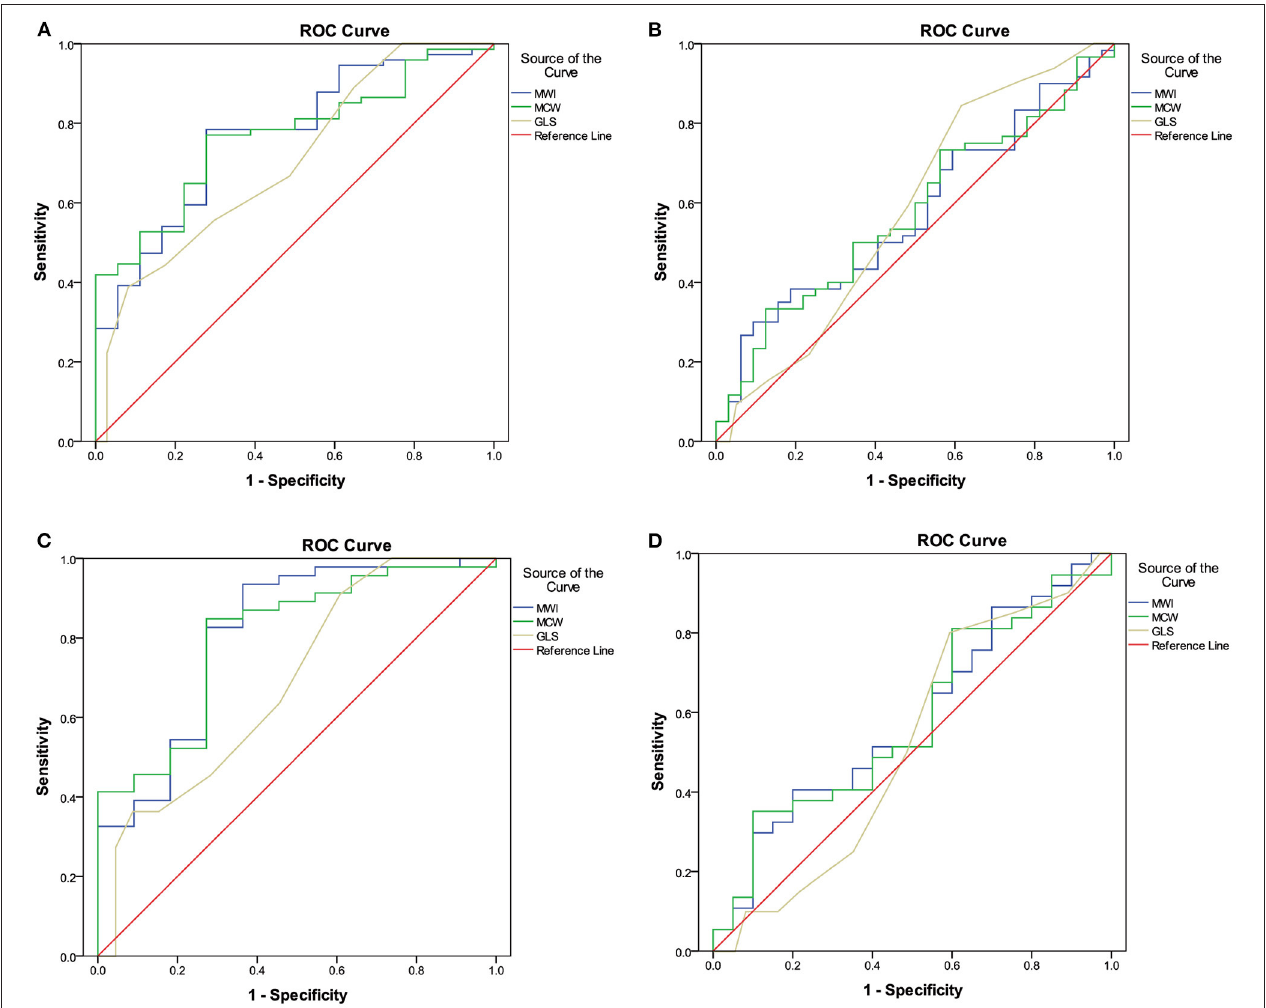
FIGURE 4 | ROC analyses of MW parameters for the diagnosis of left ventricular segments with FFR values ≤ 0.75 (A) and ≤ 0.80 (B) in the total-vessel group, and FFR values ≤ 0.75 (C) and ≤ 0.80 (D) in the single-vessel subgroup. (A) The best MWI cutoff value to detect LV segments perfused by vessels with an FFR value ≤ 0.75 in the total-vessel group was 1,623.7 mmHg% [sensitivity, 78.4%; specificity, 72.2%; AUC, 0.768 (0.653–0.883)]. (B) In the total-vessel group, the best cutoff value was 1,962.4 mmHg% [77.0%; 72.2%; 0.767 (0.661–0.872)] for MCW. (C) In the single-vessel subgroup, the best cutoff value was 1,412.1 mmHg% [93.5%; 63.6%; 0.808 (0.652–0.965)] for MWI. (D) In the single-vessel subgroup, the best cutoff value was 1,943.3 mmHg% [(84.8%; 72.7%; 0.800 (0.657–0.943)] for MCW. FFR, fractional flow reserve; MW, myocardial work; ROC, receiver operator characteristics.